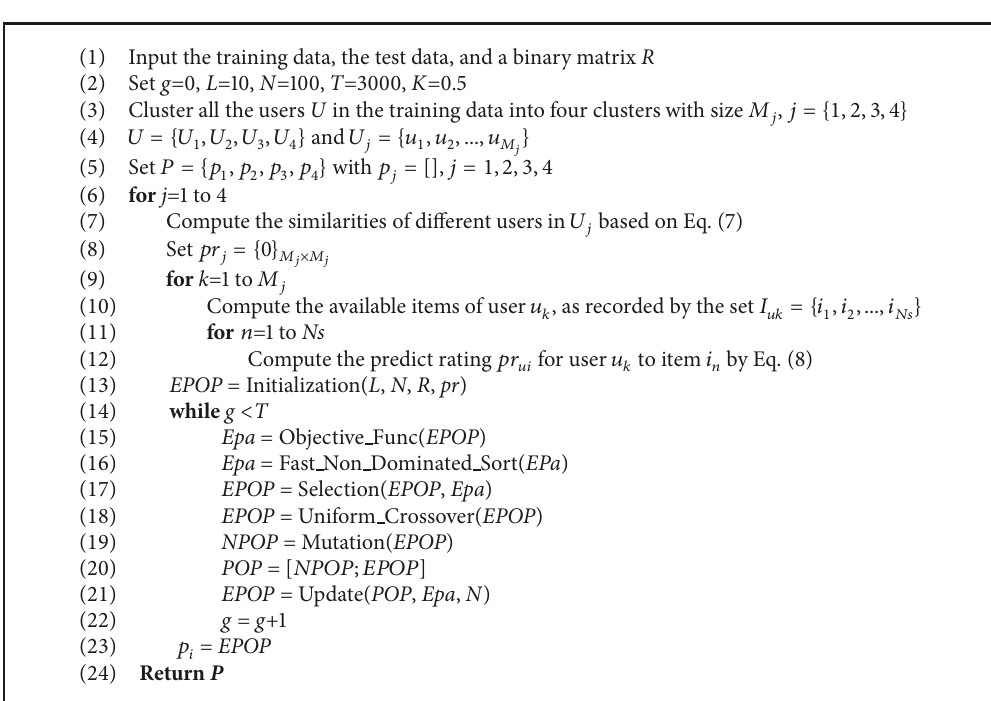
Algorithm 1: Framework of